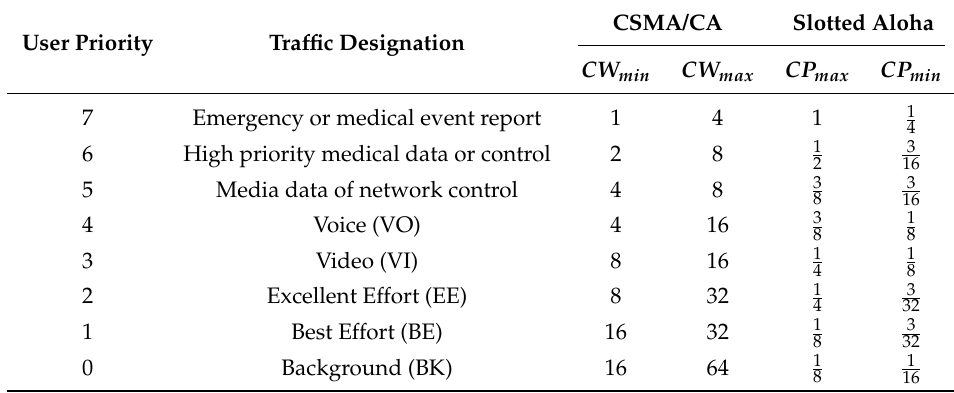
Table 1. CW bounds for the CSMA/CA, and CP limits for slotted Aloha of